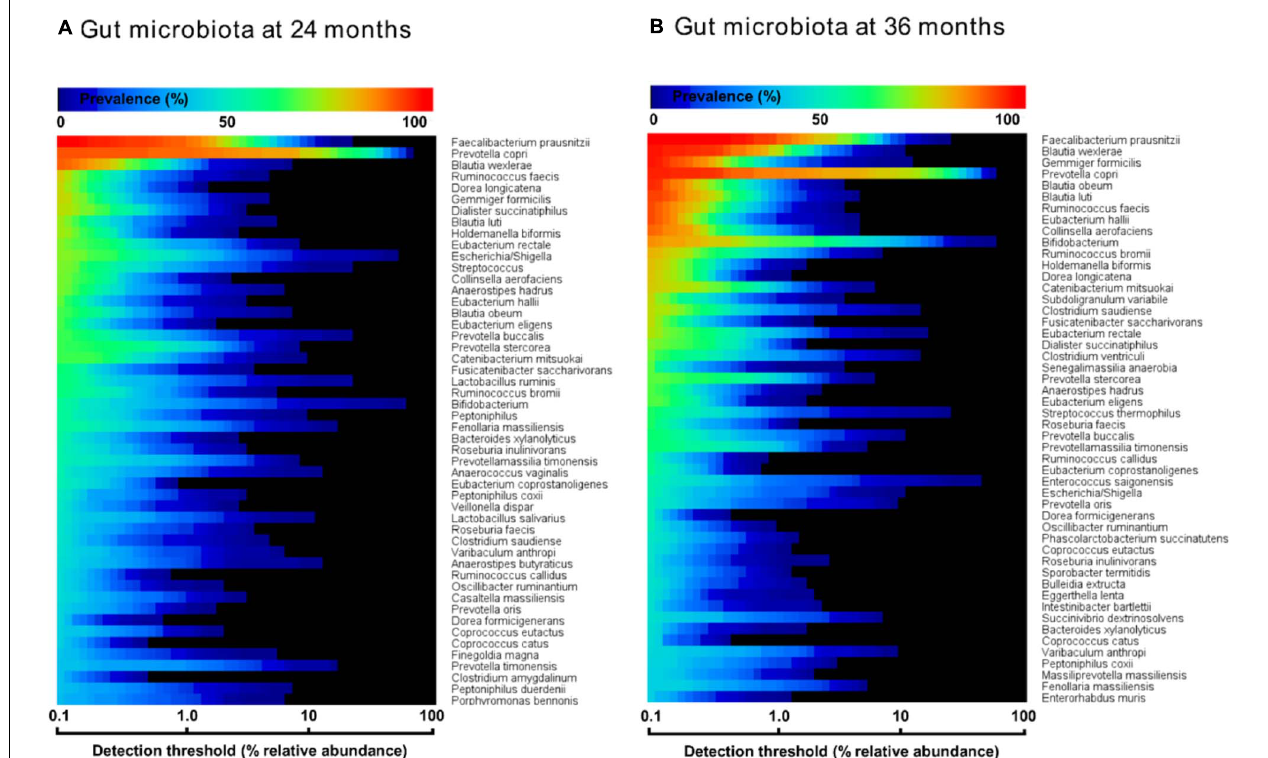
FIGURE 3 | Heat maps of top 50 most prevalent bacteria in the fecal microbiota of Ugandan children at the age of 24 months (A) and 36 months (B) , as determined by 16S rRNA gene amplicon sequencing. The color gradient indicates the prevalence (see top-legend) at the detection threshold of the relative abundance (%) presented at the x -axis with a logarithmic scale. The y -axis indicates the order of most prevalent bacteria at a detection threshold of 0.1% abundance. Unambiguous species assignments include Dialister succinatiphilu , Dialister propionicifaciens ; Lactobacillus salivarius , Lactobacillus ruminis ; Clostridium saudiense , Clostridium